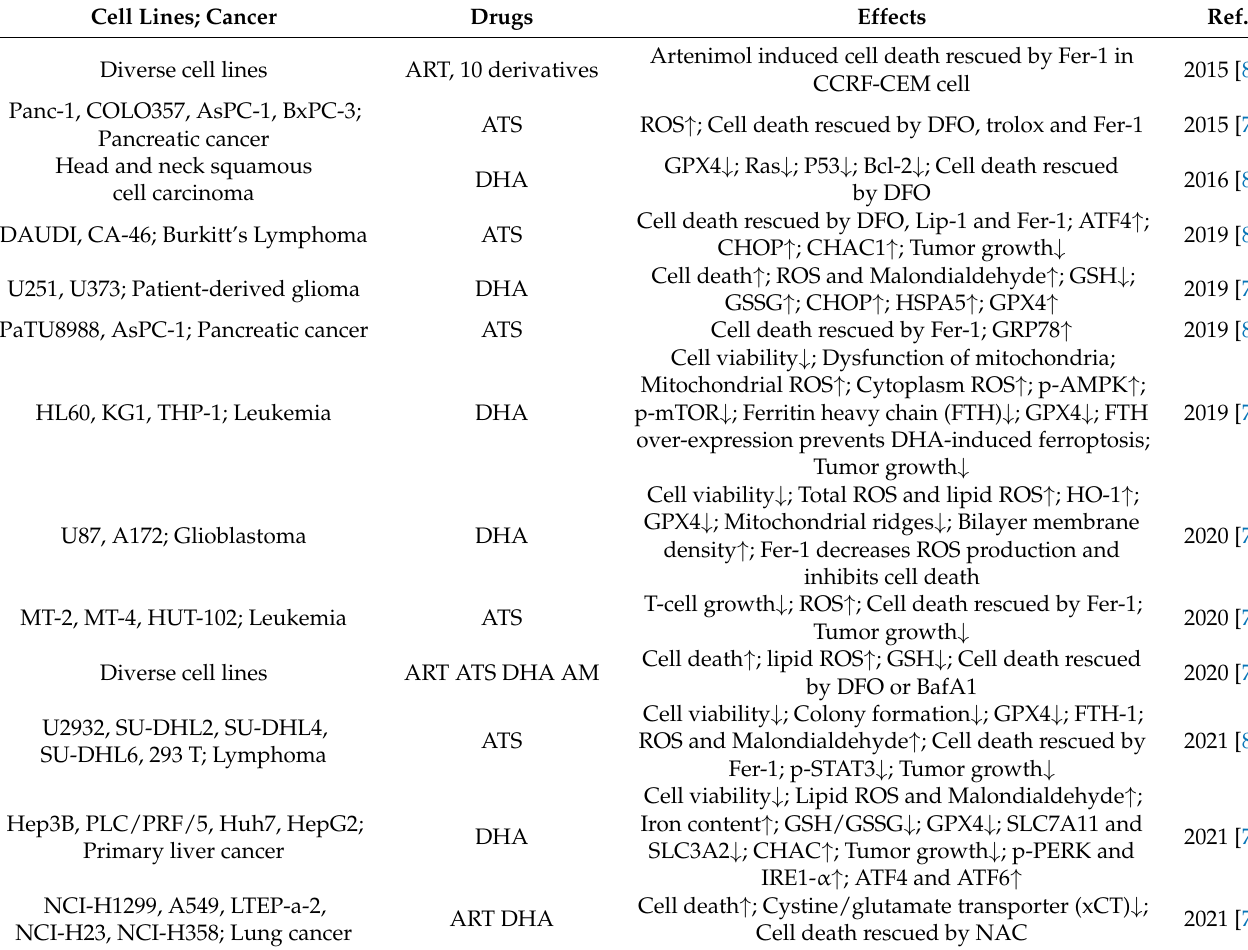
Table 2. List of studies from the last 10 years investigating the effect of ART-type drugs related to ferroptosis in cancer cells with information on the model systems used, the ART-type drugs tested and the major findings of the